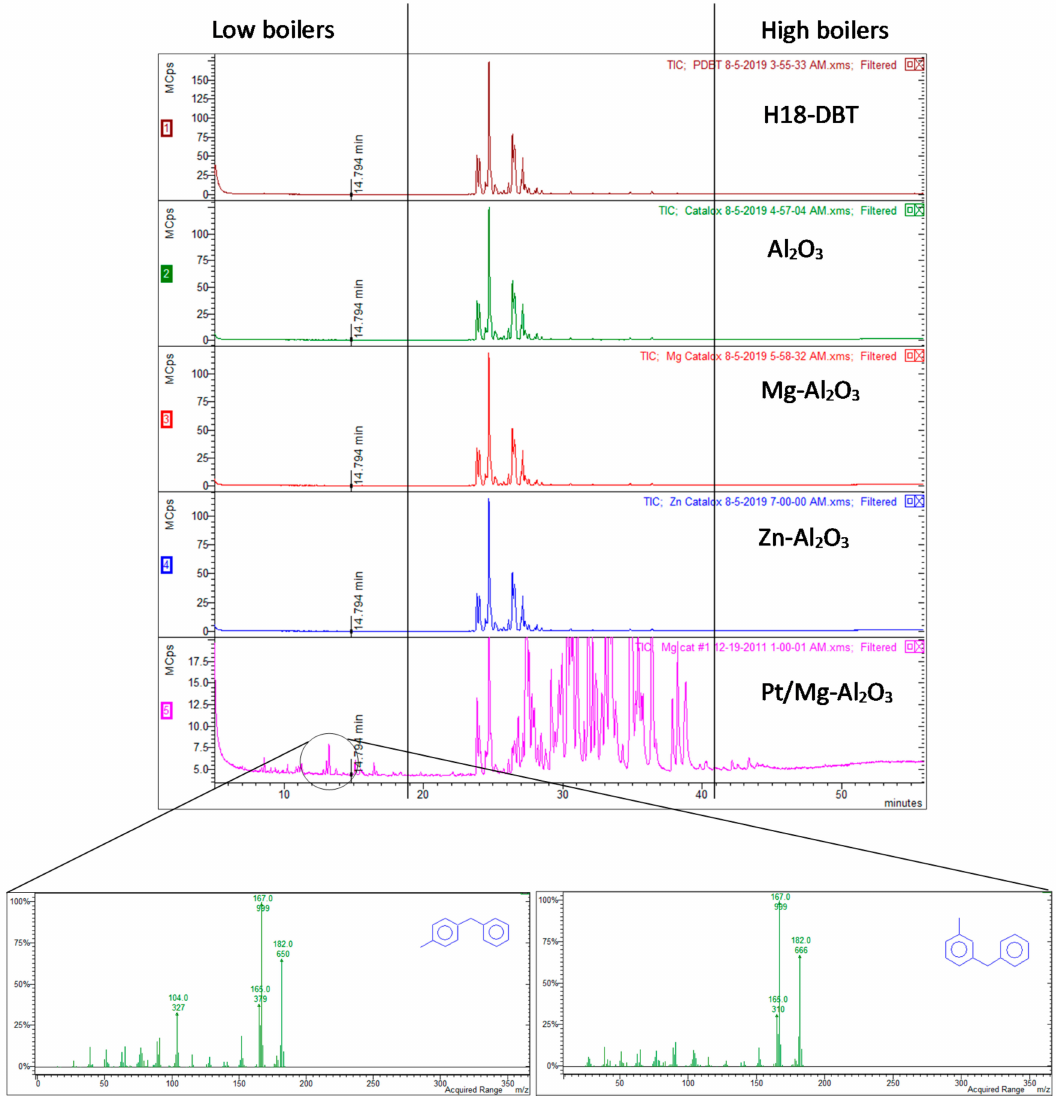
Figure 12. The chromatograms of H18-DBT heated at 300 ◦ C for 90 min with and without support, and a representative chromatogram and mass spectrometry (MS) spectra showing low boiling point by-products of Pt/Mg-Al 2 O 3 catalyst. National Institute of Standards and Technology (NIST) 17 mass spectral library was used to identify the